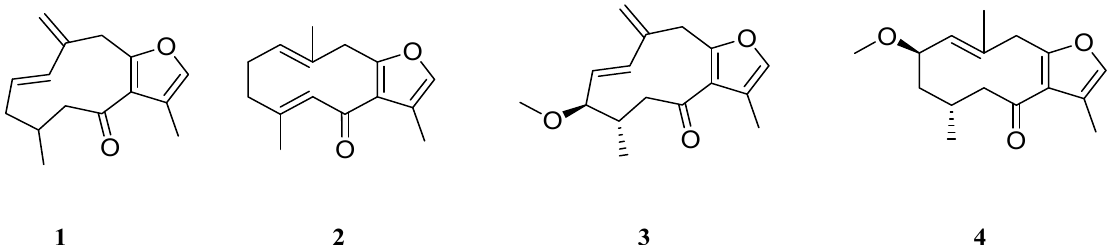
Figure 1. Isolated compounds from C. erythraea